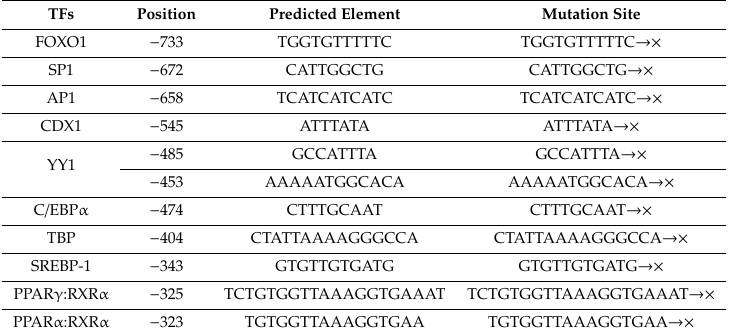
Table 3. Primers used for site-directed mutations of transcription factors (TFs) on common carp acsl6 core promoter.